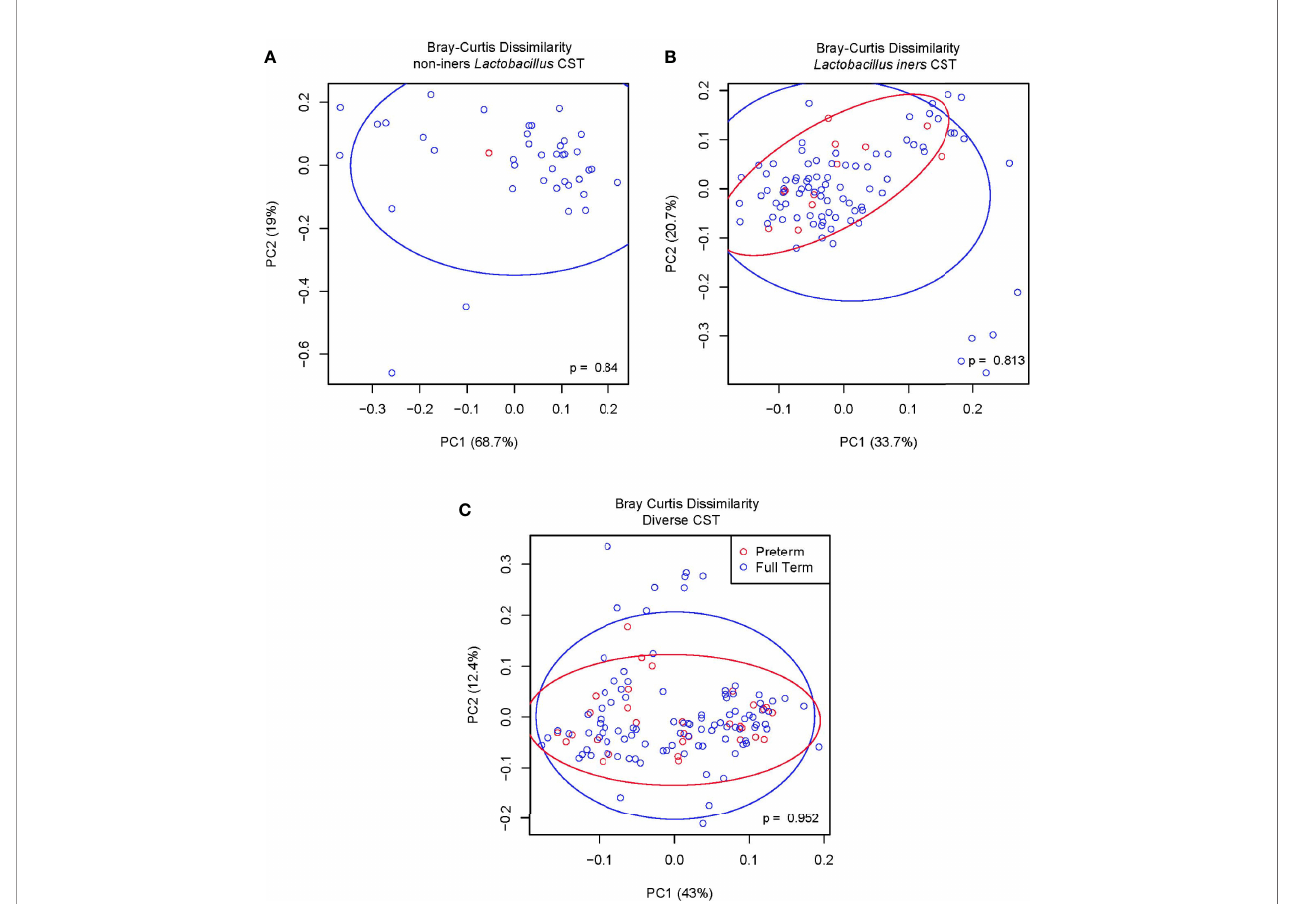
FIGURE 4 | (A) Bray-Curtis dissimilarity non-iners Lactobacillus CST. (B) Bray-Curtis dissimilarity Lactobacillus iners CST. (C) Bray Curtis dissimilarity diverse